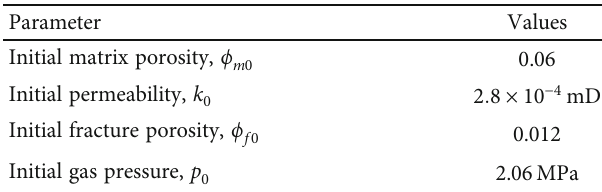
Table 3: Calculation parameters used in